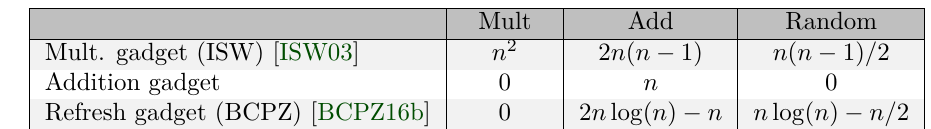
Table 3: Operation counts for ISW +